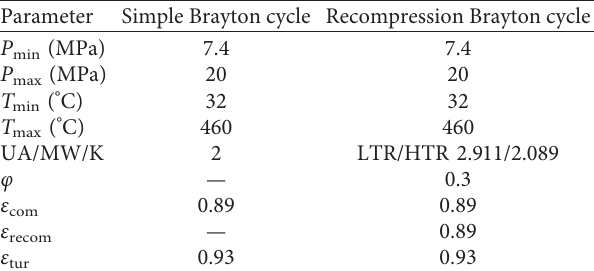
Table 4: Initial cycle parameter for simple and recompression Brayton cycles.